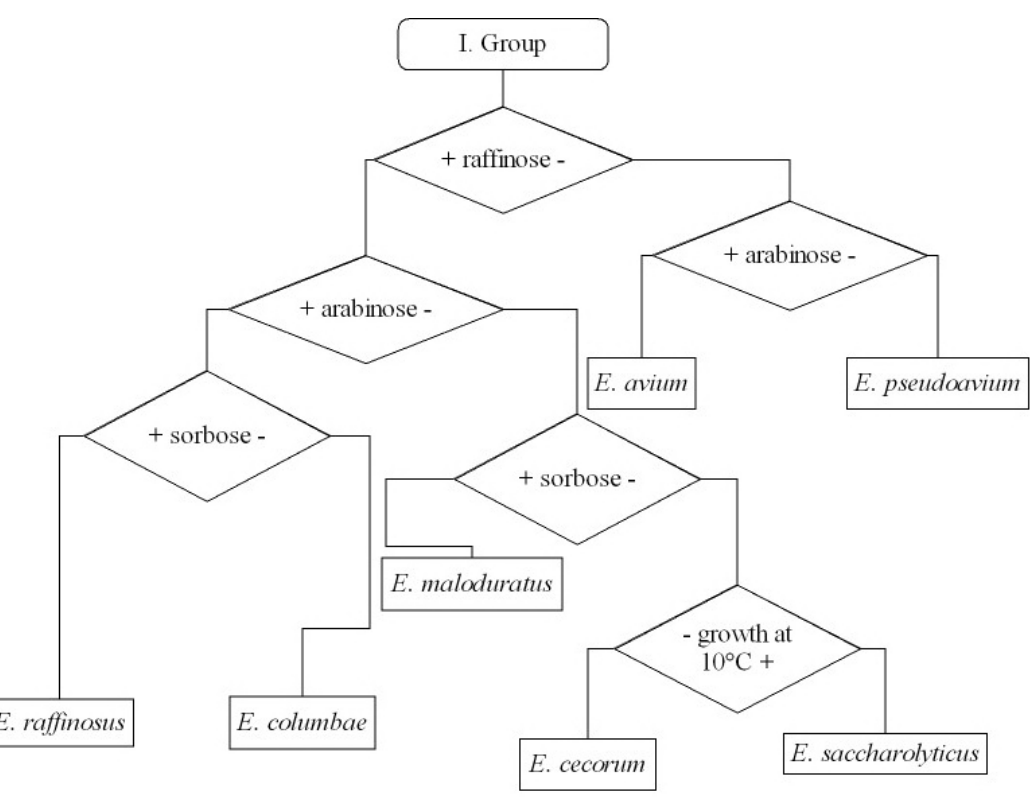
Figure 22. Identification of the members of group I. of enterococci by biochemical re- actions